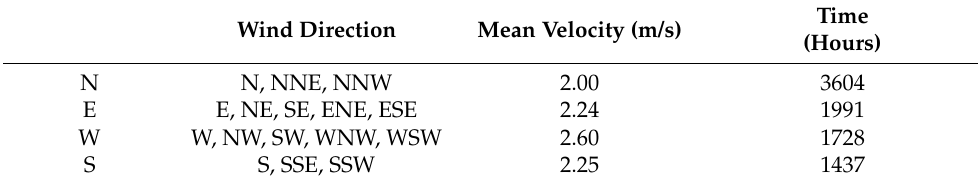
Table 3. Wind direction